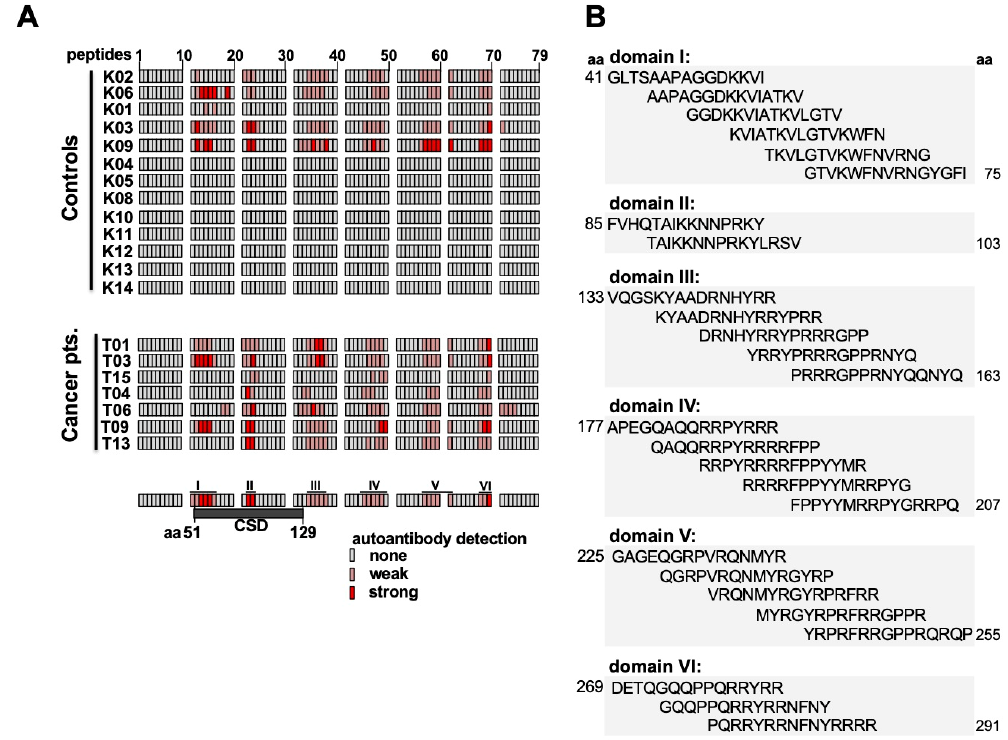
Figure 6. Mapping of autoantibodies against linear epitopes within cold shock protein YB-1 by overlapping peptide array. ( A ) Summary of all probed serum / plasma samples with detected peptides highlighted. Signal of detected fragments are semi objectively depicted none, weak ( < 100k), and strong ( > 100k). For densitometry readings compare with Table S4. ( B ) The amino acid sequence of common cancer epitopes from Figure 6A.